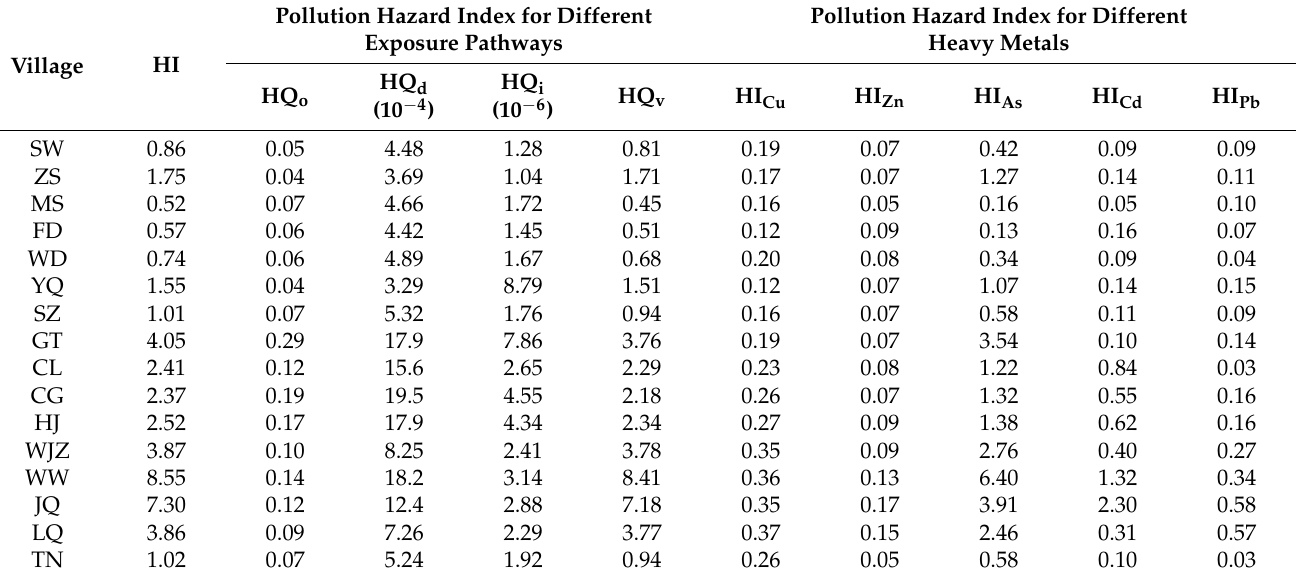
Table 3. Physical vulnerability assessment results of different